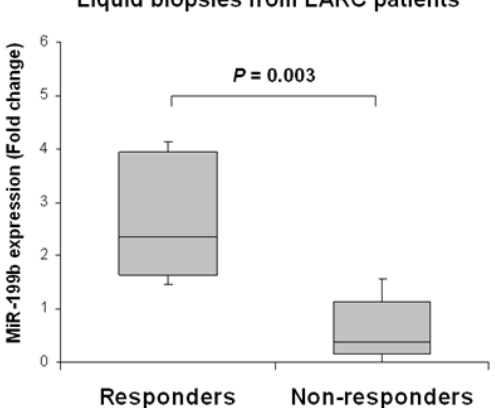
Figure 5. MiR-199b downregulation associates with lack of response to nCRT in pre-treatment samples of LARC patients. The box-plot shows miR-199b expression levels in LARC patients stratified by response or non-response to nCRT treatment. The responder group corresponds to cases with moderate or complete response (RYAN 0 and 1), including cases following the W&W protocol. The non-responder group includes those with minimal or none complete response (RYAN 2 and